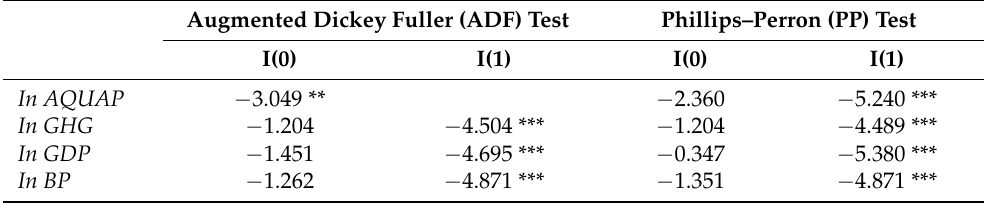
Table 2. Unit root